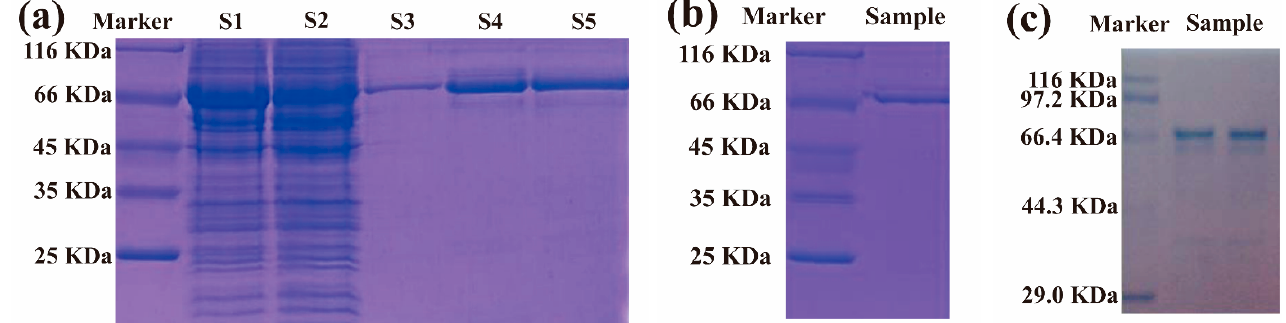
Figure 1. The SDS-PAGE and Western blot analysis of CPD photolyase protein. ( a ) SDS-PAGE analysis during Ni-NTA affinity chromatographic purification process (S1: sample loading; S2: effluent; S3–S5: fraction with gradient elution); ( b ) SDS-PAGE analysis of purified CPD photolyase protein; ( c ) Western blot analysis of purified CPD photolyase protein.